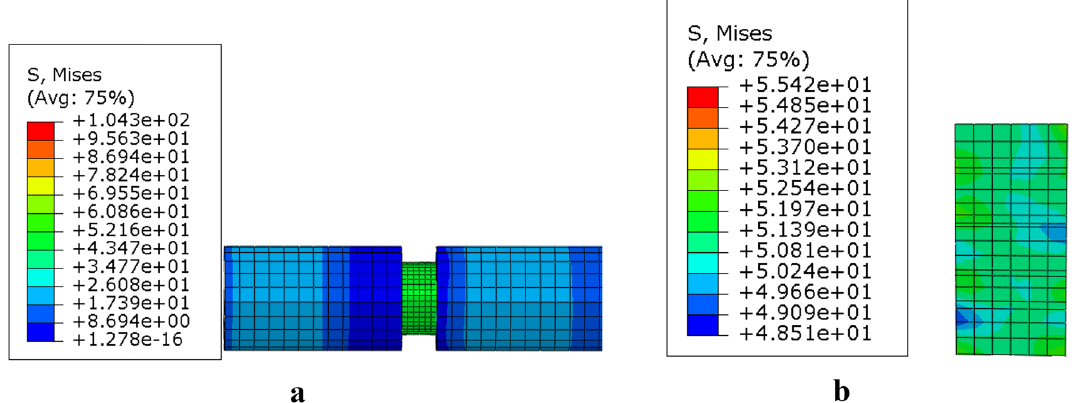
Figure 8. Von Mises stress cloud at different times: ( a ) t = 203 μs, ( b ) von Mises stress cloud on the